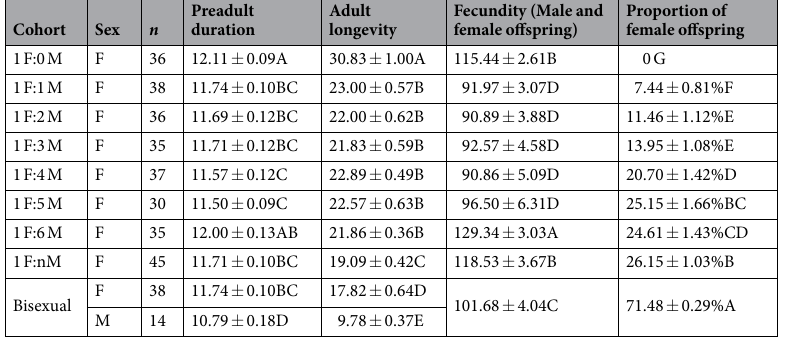
Table 1. Preadult duration, adult longevity, total fecundity and proportion of female offspring of Frankliniella occidentalis in different treatments of arrhenotokous and bisexual reproduction. Means in the same column followed by the same upper case letter denotes no significant difference between different